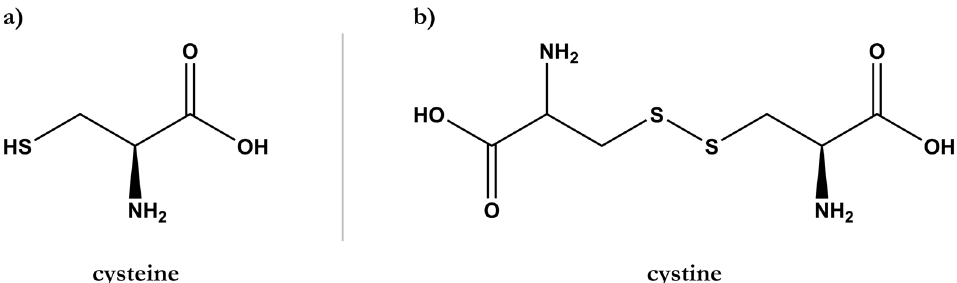
Figure 1. Chemical structures of ( a ) cysteine amino acid and ( b ) cystine dimer formed by disulfide bonds between two cysteine molecules.